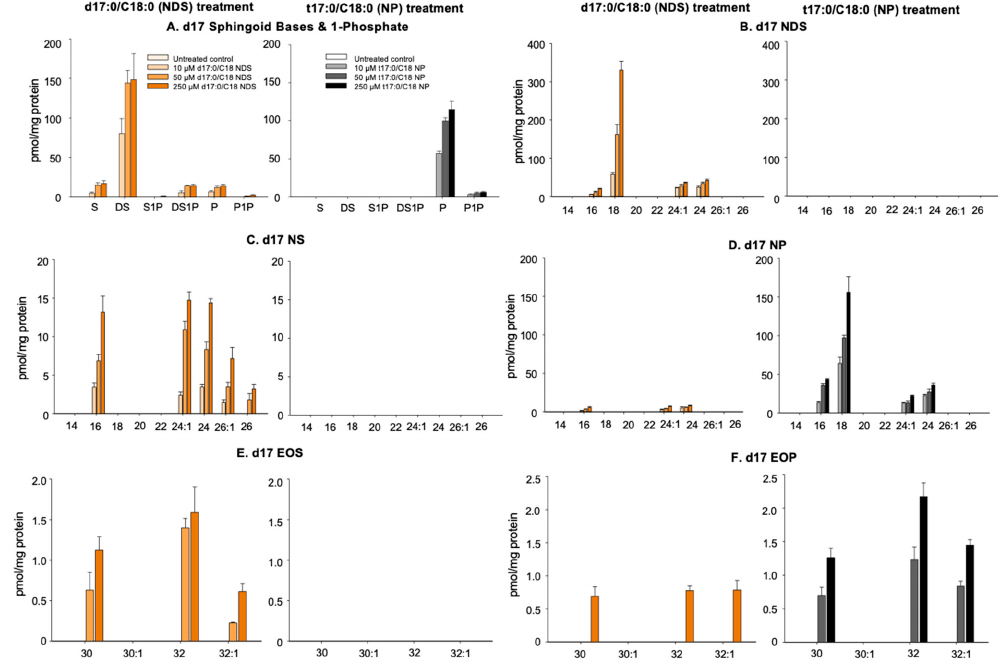
Figure 2. Fate of exogenous 17Cer and 17NP. Cer species containing ß-hydroxy FA, 6-hydroxy sphingosine (H), 4,14-sphingadiene (SD), and omega-hydroxy Cer were not analyzed. n = 3, * p < 0.01 vs. Mean ± SD. see details in Section 2.